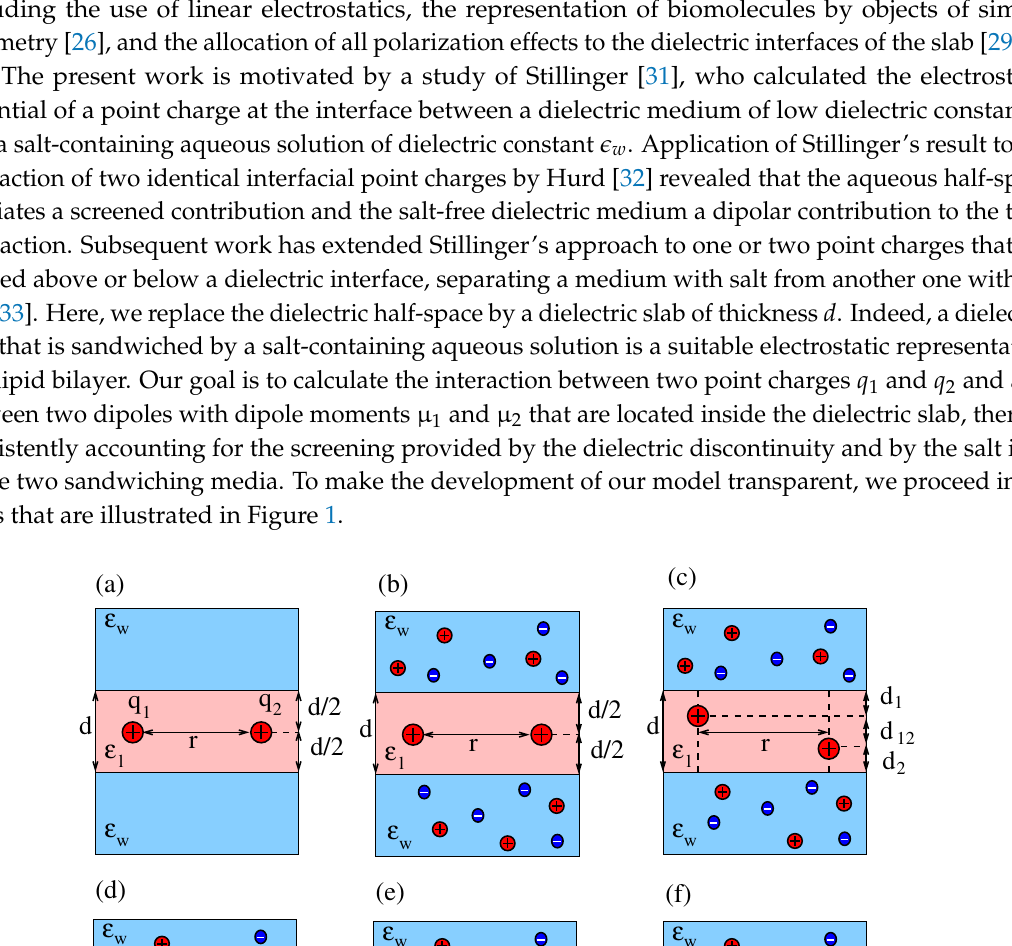
(cid:113) + r 2 and d 2 12